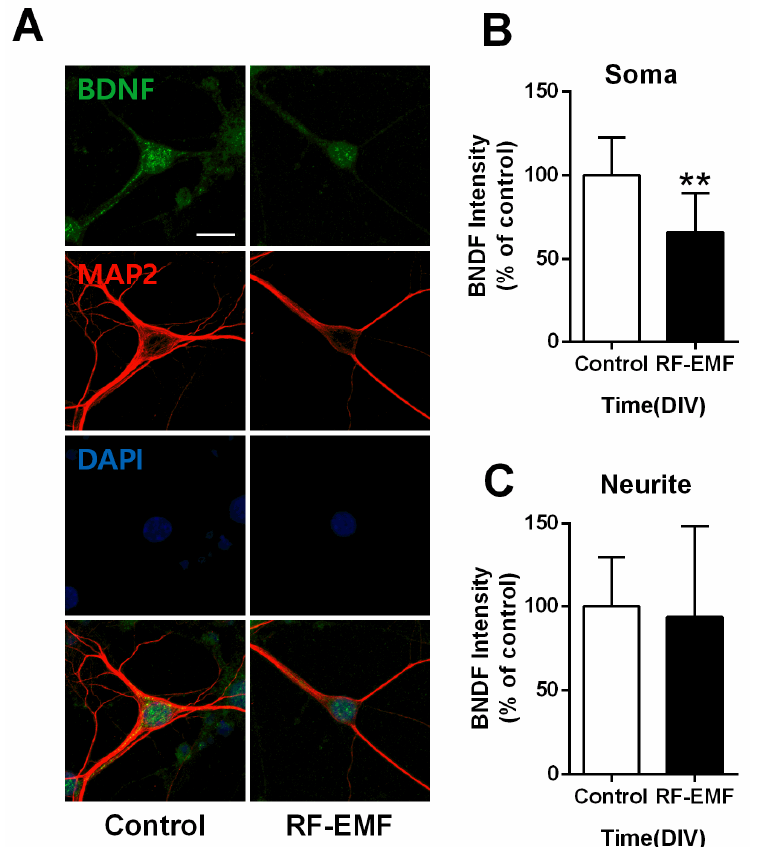
Figure 6. Exposure to RF-EMF decreased somatic BDNF expression in primary cultured hippocampal neurons. ( A ). Confocal images display hippocampal neurons expressing BDNF (green), MAP2 (red), and nuclei (DAPI, blue). Expression of BDNF in hippocampal neurons was analyzed on DIV 9. ( B , C ). Summary of changes in BDNF expression in the soma and neurites of cultured hippocampal neurons. Data are expressed as means ± SD. Statistical significance was evaluated using the Student’s t -test. ** p < 0.01 vs. control (control n = 18 mice, RF-EMF n = 18 mice). Scale bar = 15 μm.